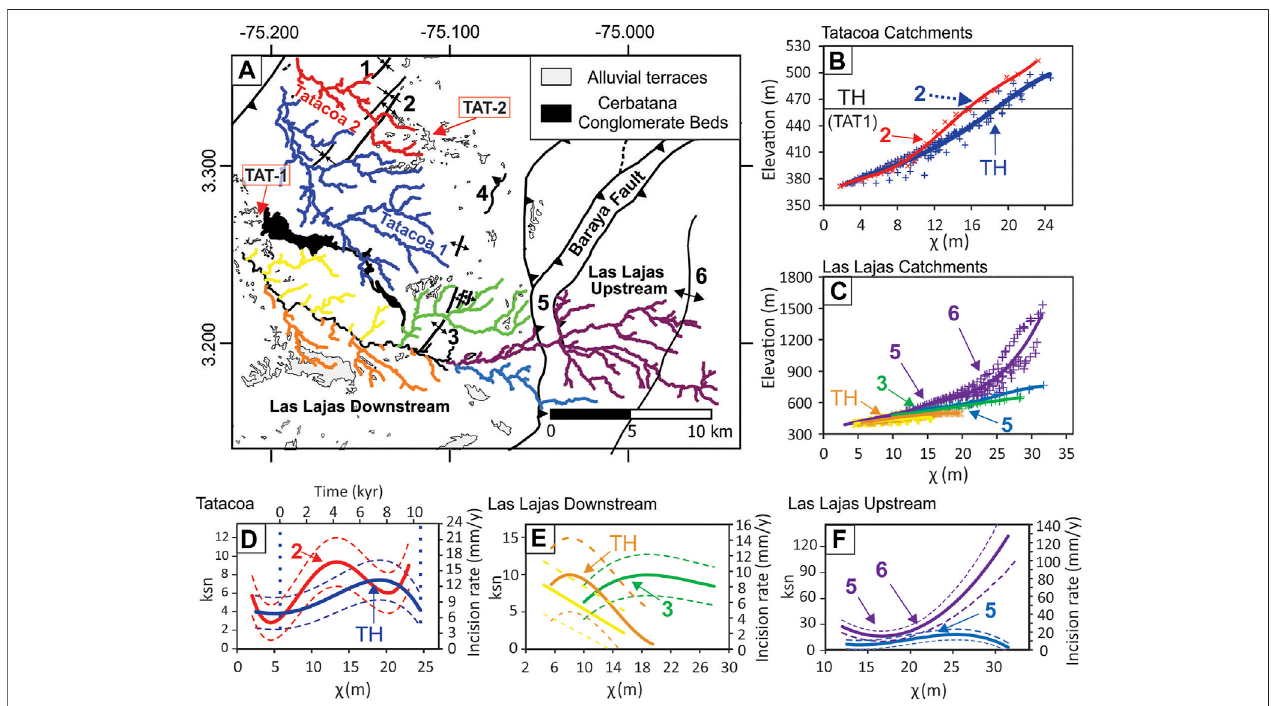
FIGURE9| χ — pro fi les andincisionrates. (A) Sub-catchment ’ slocations, color-codedforall graphs;The numbers in (A) ,indicatedbyarrows in (B – F) aretectonic structures: (1) Peralta Anticline; (2) Cerro Gordo Anticline; (3) La Becerrera Anticline; (4) Andalucia Fault; (5) Baraya Fault; and (6) La Pampa Anticline; (TH) is the terrace height of the TAT 1. (B) χ — plot of the internal Tatacoa drainage system, the crosses indicate the DEM-derived χ — plot and the lines of the best- fi tted polynomial curve. (C) χ — plot of the Las Lajas sub-catchments. (D) ksn index, sampled from the derivative of the best- fi tted polynomial curve, for the Tatacoa catchments (see Section3.2.2 ).TheincisionrateswerecalculatedfromtheK=17.55×10 − 4 ±3.54×10 − 4 . χ -valueswereconvertedintotimeintheregionsunaffectedbyfoldsalongthe Tatacoa 1catchment (blue); (E) ksn index of the Las Lajas downstream sub-catchments; and (F) Ksn index of the Las Lajas upstream sub-catchments. Incision rates in (E) and the (F) were calibrated with the K = 17.55 × 10 − 4 ± 3.54 × 10 − 4 ( Supplementary Table S7 ).